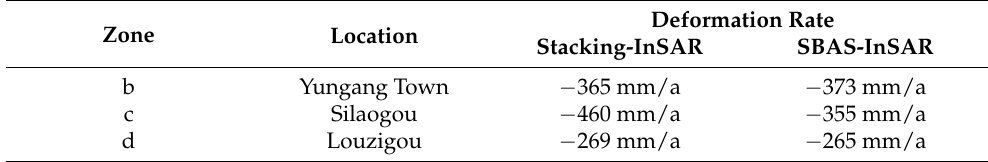
Table 2. Maximum displacement rate results monitored by stacking-InSAR and SBAS-InSAR.